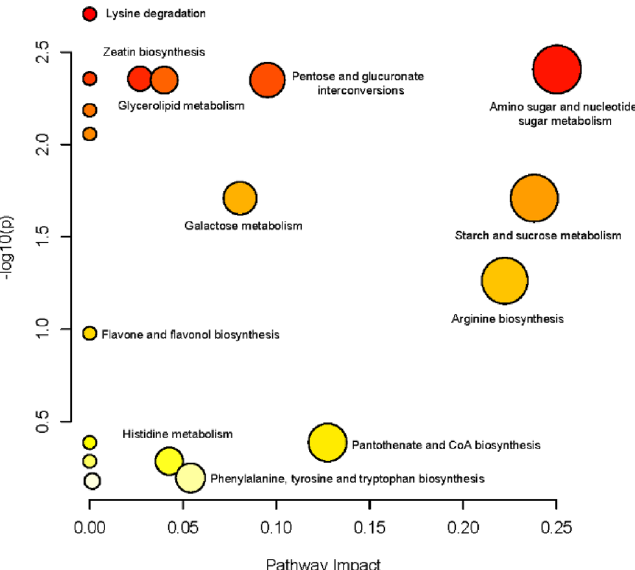
Figure 5. KEGG metabolic pathway classification of the differential metabolites. The node color is based on the p value, white and red colors indicate lower or higher p value, respectively. The node radius is based on the pathway impact value, small and large radius indicate lower or higher impact value,